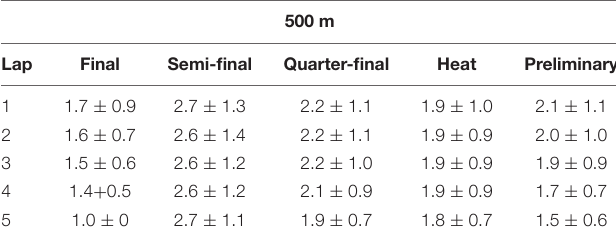
TABLE 2 | Mean value and standard deviation of lap rankings for 500 m champions.